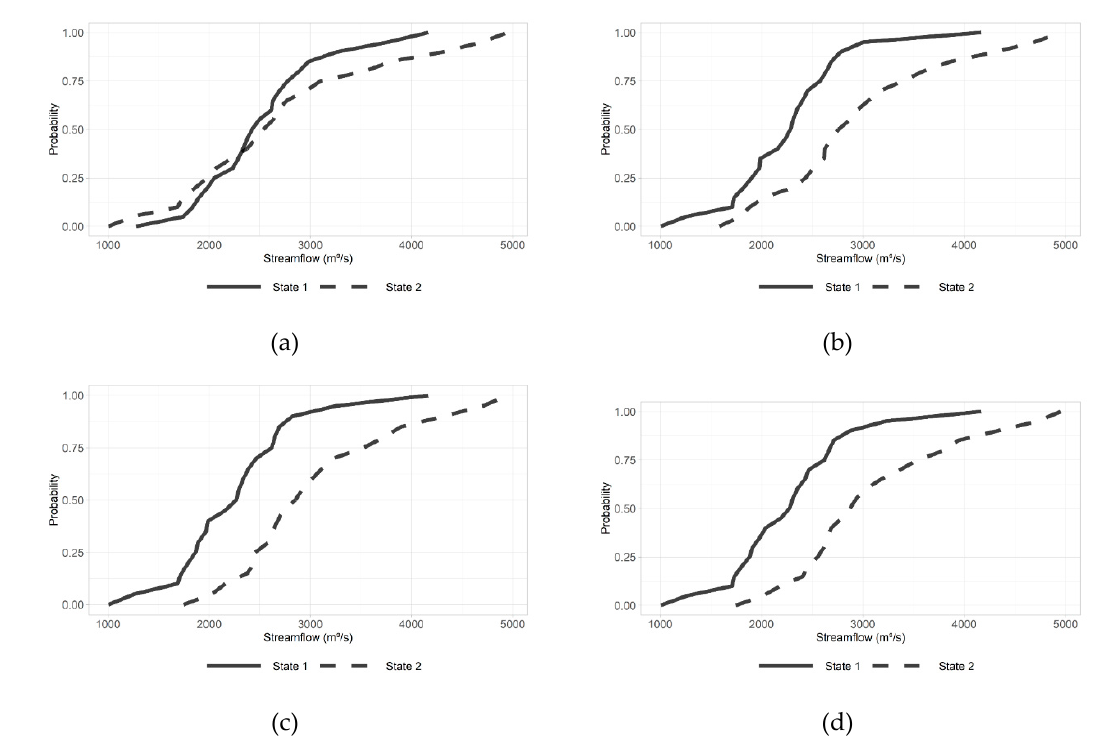
Figure 6. The cumulative distribution functions (CDFs) of the series without being decomposed by the wavelet transform for the state classification using ( a ) BFAST, ( b ) adjusted SRI (Ad-SRI), ( c ) PELT, and ( d ) HMM.